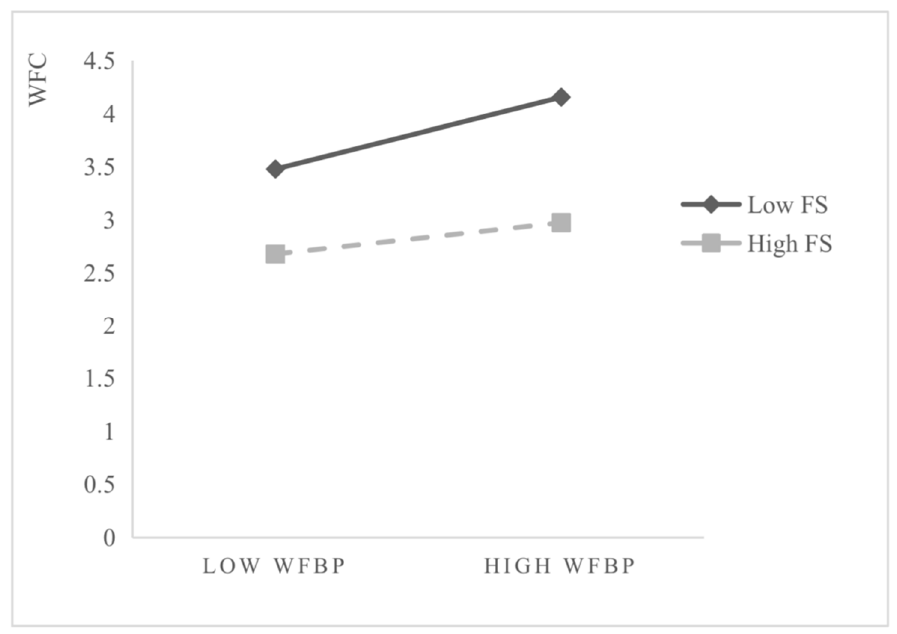
Figure 3. Interaction effect of family support.